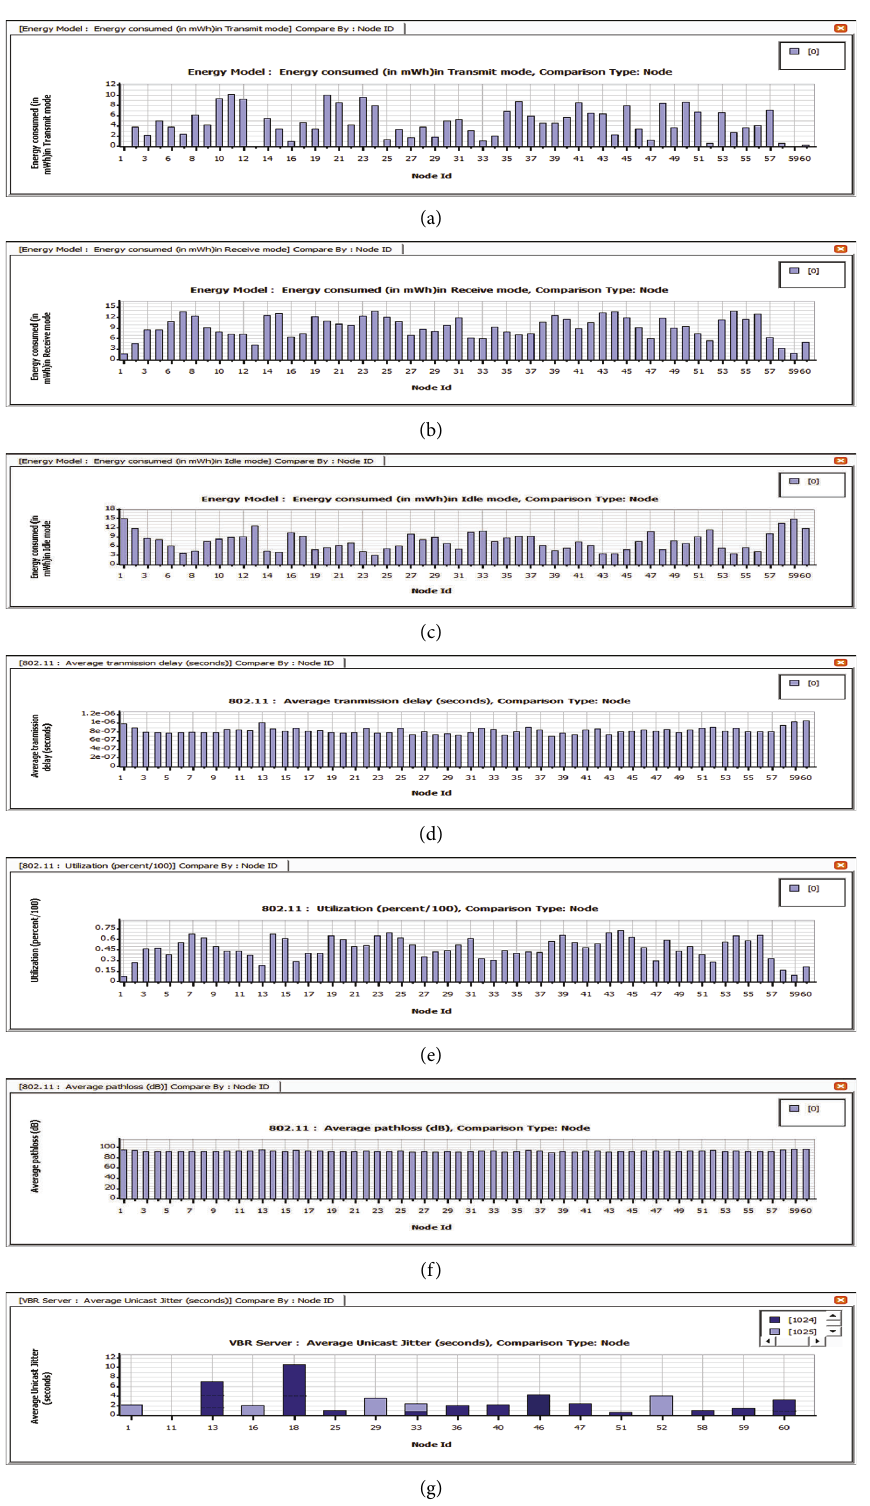
Figure 20: (a) Transmit mode energy consumption of DYMO for VBR deployment. (b) Receive mode energy consumption of DYMO for VBR deployment. (c) Idle mode energy consumption of DYMO for VBR deployment. (d) Average transmission delay of DYMO for VBR deployment. (e) Percentage of utilization of DYMO for VBR deployment. (f) Average pathloss of DYMO for VBR deployment. (g) Average jitter of DYMO for VBR